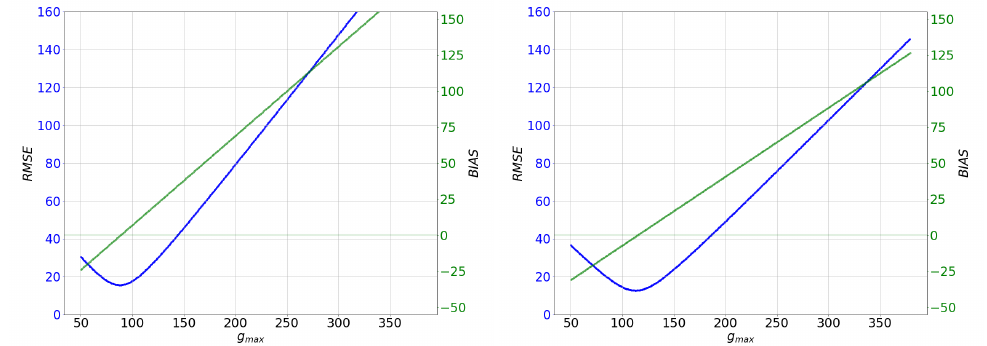
Figure 1. The dependency of the RMSE and BIAS on the g max parameter for the boreal coniferous set of parameters ( left figure ) and for the optimal set of parameters from Table 5 ( right figure ). The WoTA data are